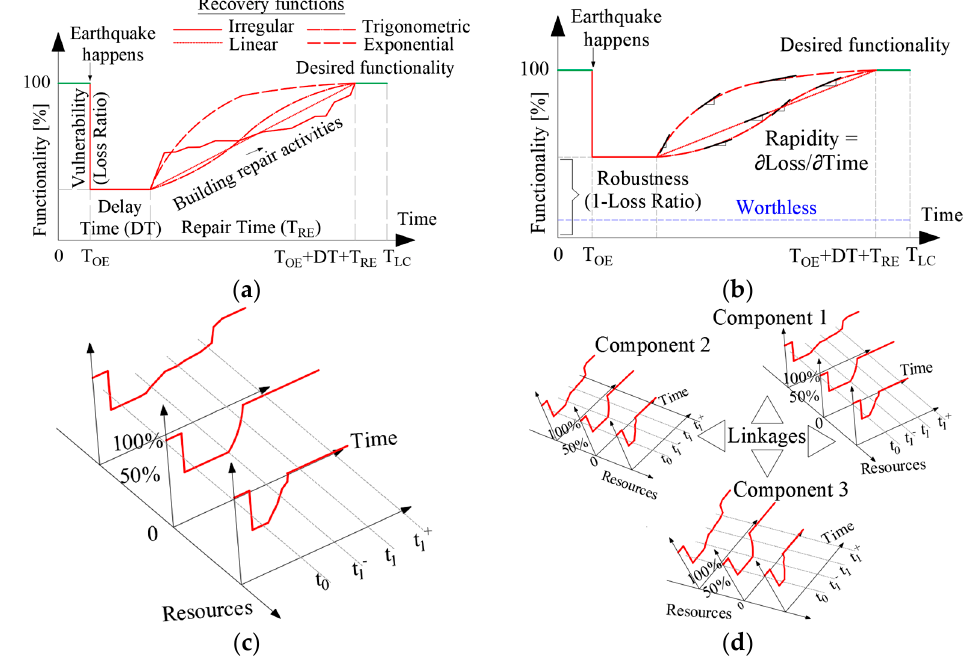
Figure 1. General components of resilience and main properties (4R) adapted from [10]. ( a ) Recovery function, ( b ) Robustness and Rapidity, ( c ) Resourcefulness, and ( d )